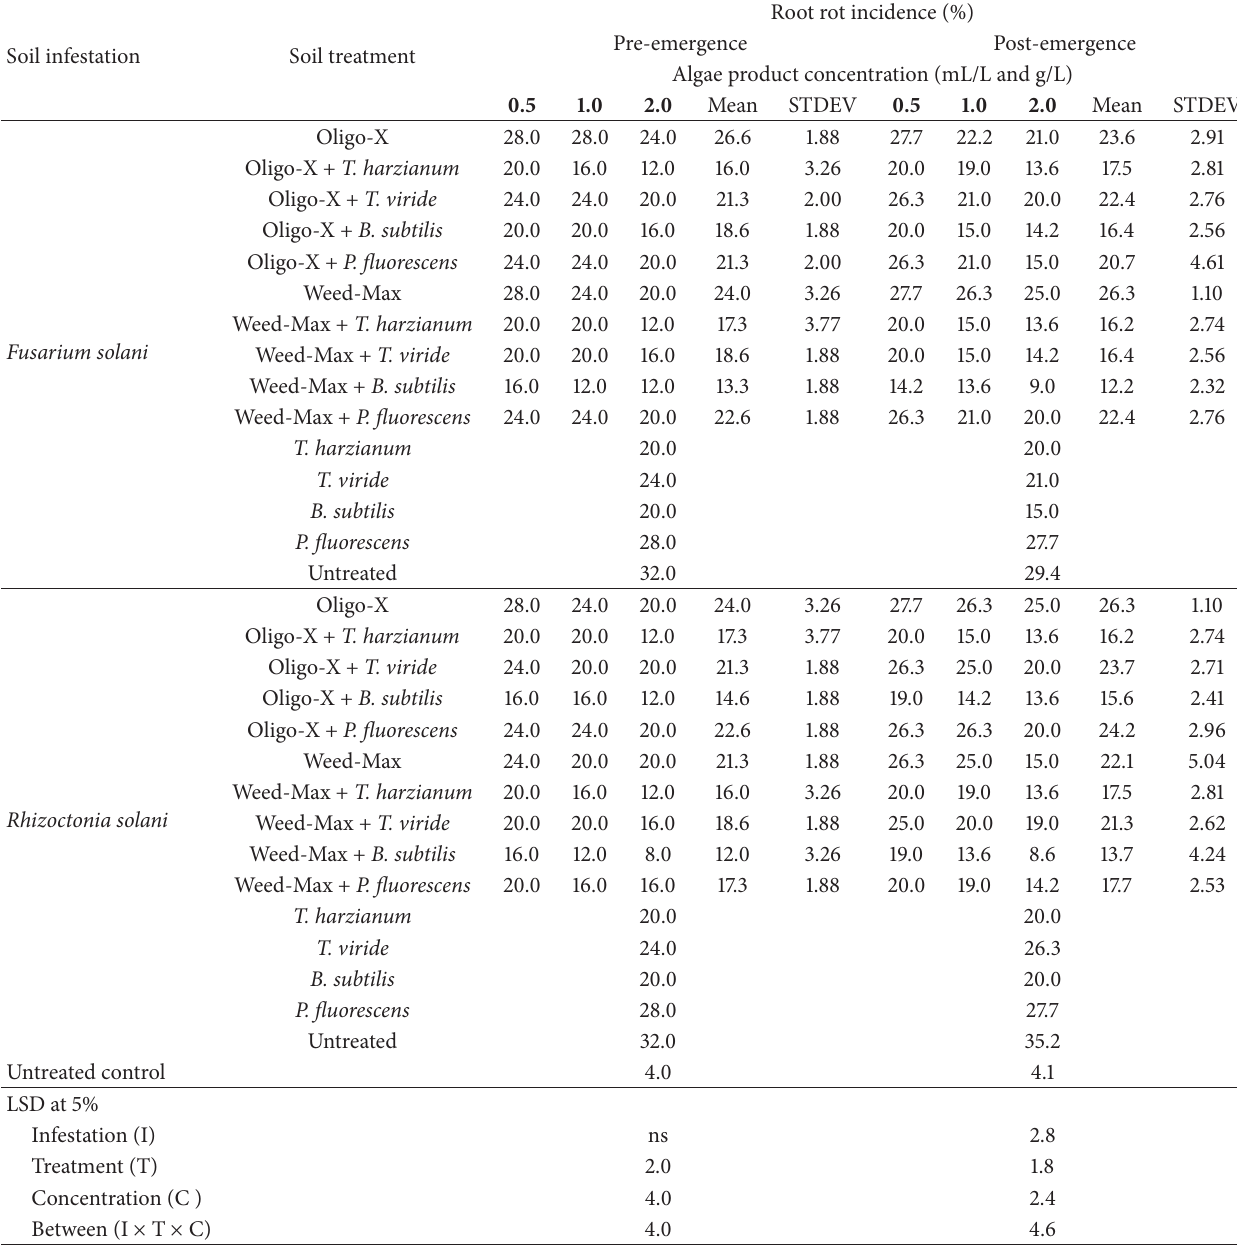
Table 2: Effect of integrated soil treatment with algae compound and bio-agents against root rot incidence of tomato under greenhouse